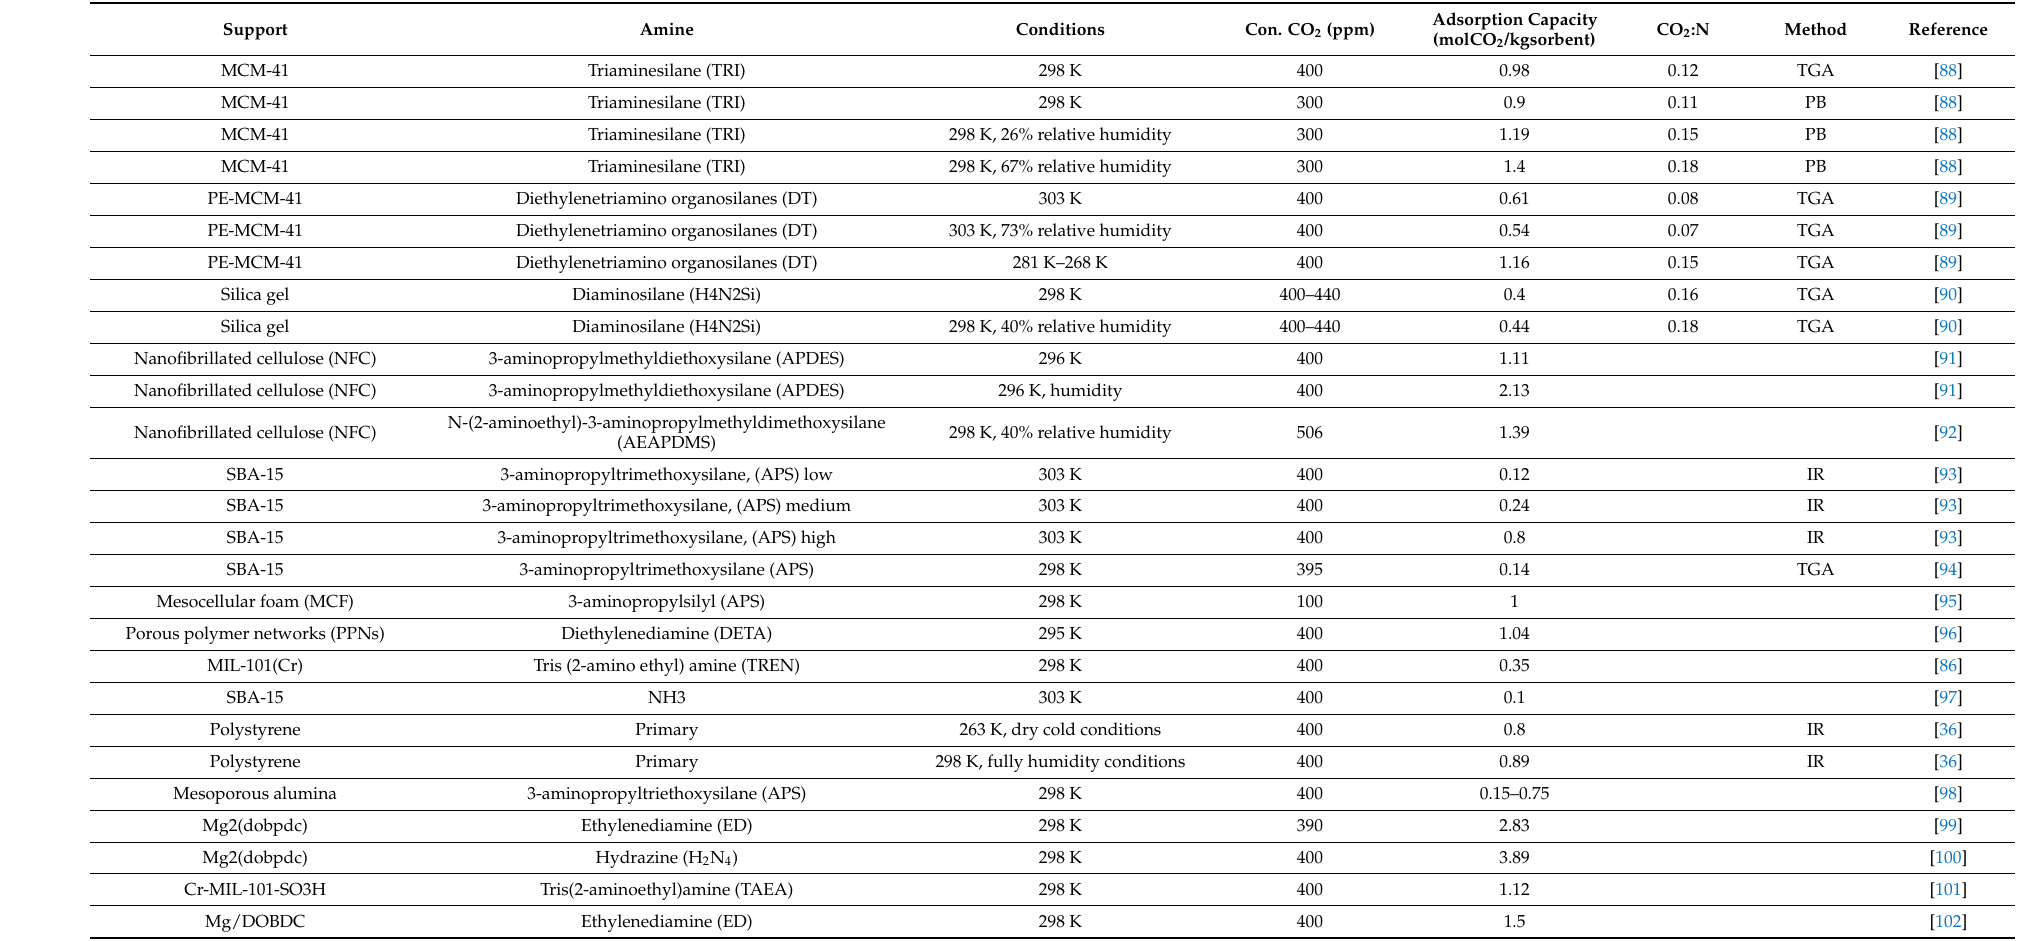
Table 3. Class II amine-functionalized